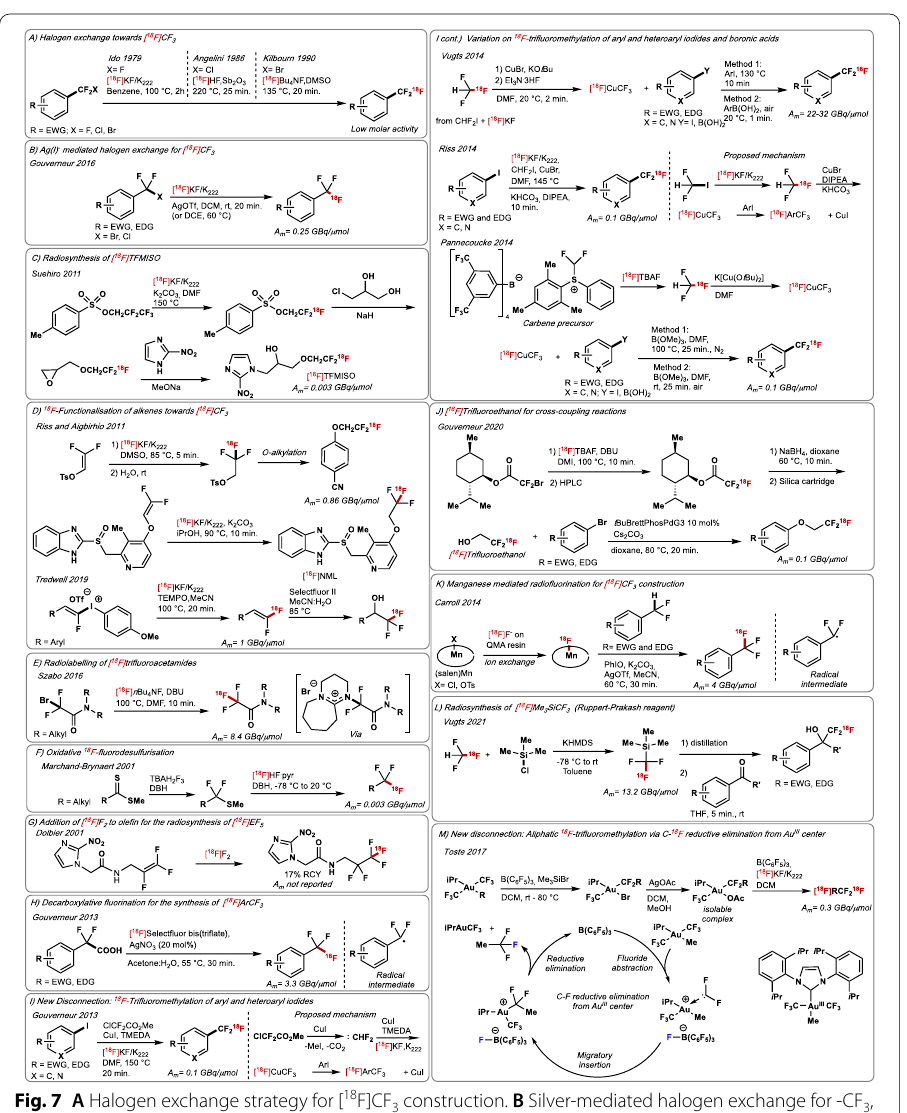
Fig. 7 A Halogen exchange strategy for [ 18 F]CF 3 construction. B Silver-mediated halogen exchange for -CF 3 ,